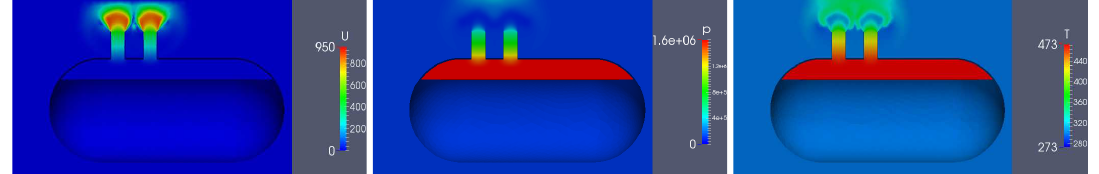
Figure 8. The velocity, pressure and temperature distribution in PRT and interior space at 0.004